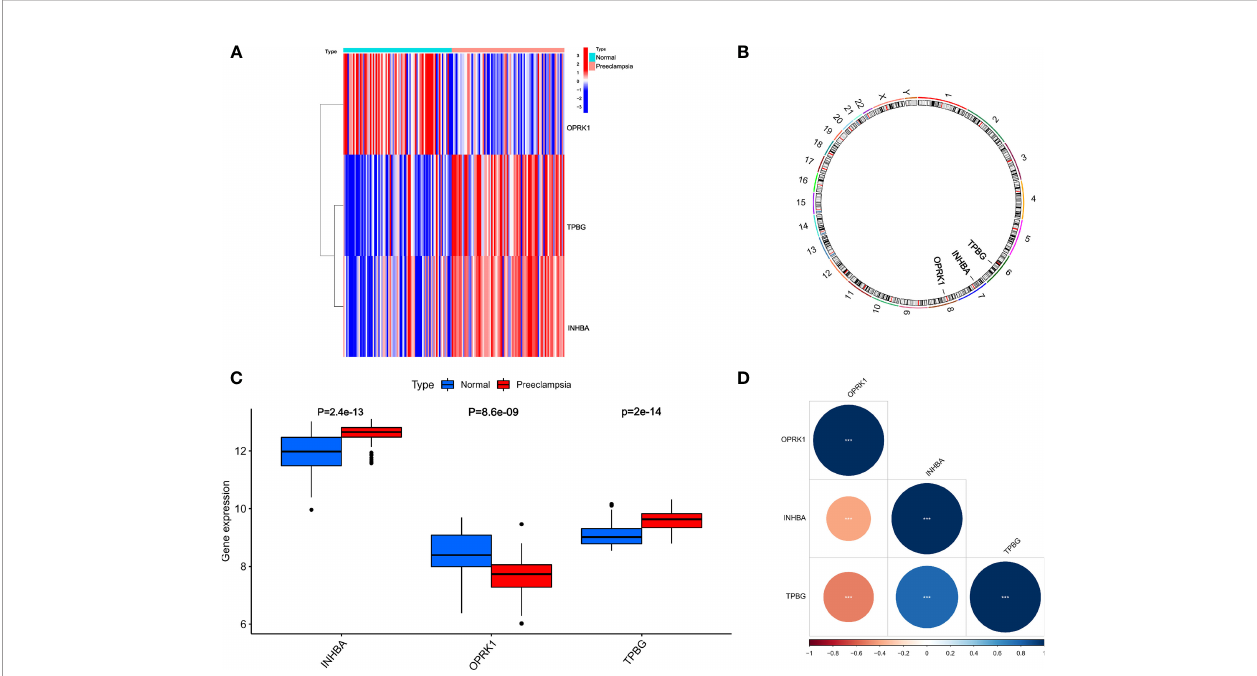
FIGURE 5 | Relative expression level and correlation among INHBA, OPRK1 and TPBG . (A) The heatmap of INHBA, OPRK1 and TPBG between PE group and non-PE group. (B) The chromosomal locations of INHBA, OPRK1 and TPBG . (C) The relative expression level of INHBA, OPRK1 and TPBG between PE group and non-PE group. (D) The correlation among INHBA, OPRK1 and TPBG